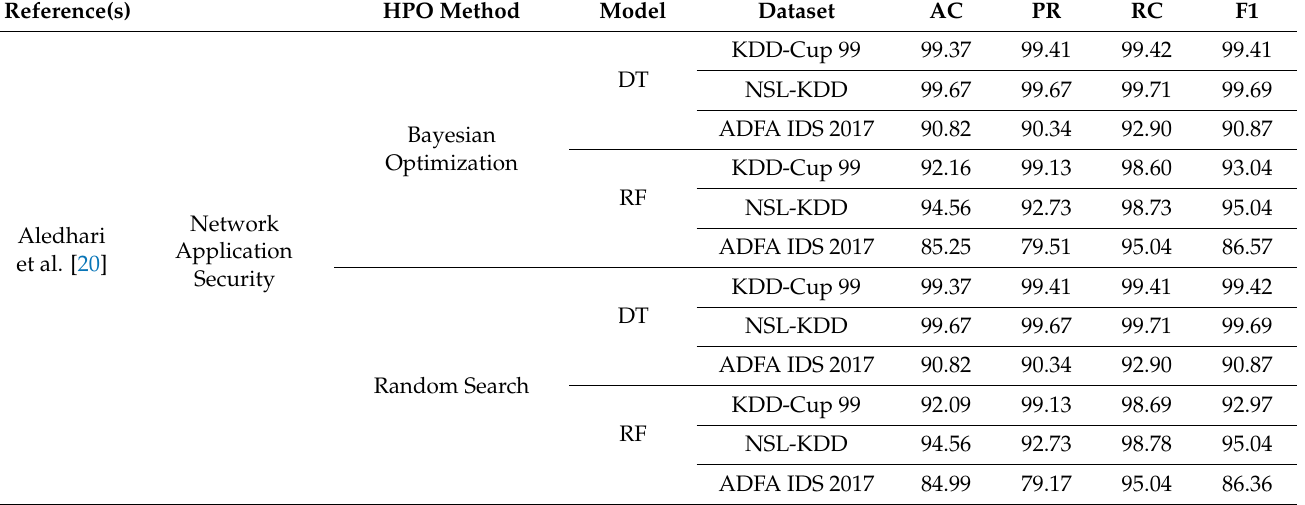
Table 2. Impact of HPO in learning models based on existing